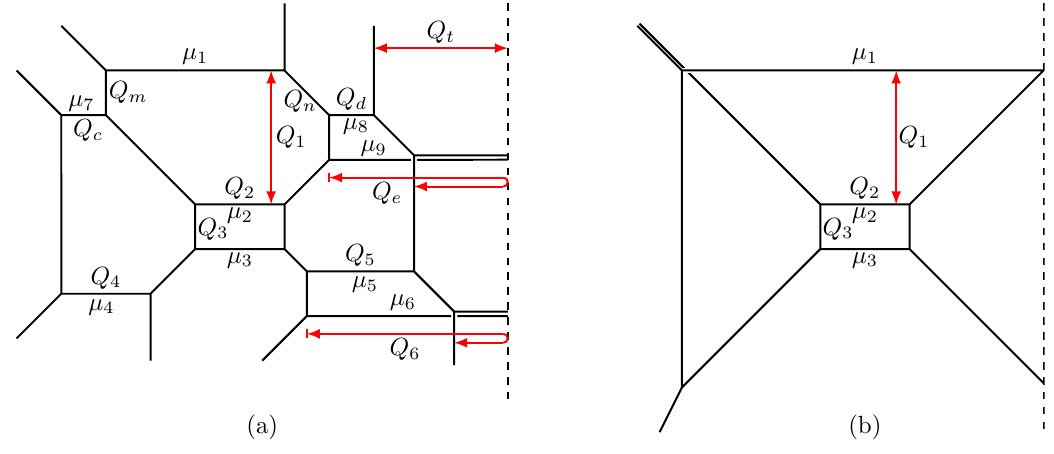
Figure 16 . (a) The D 4 -type quiver theory. (b) SU(3) theory at CS level 7.